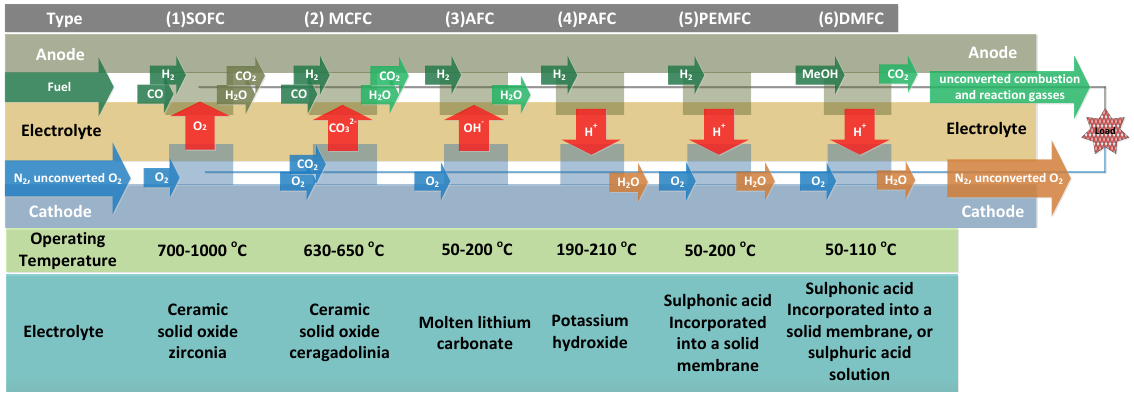
Figure 2. Schematic representation of a proton exchange membrane fuel cell (PEMFC) and a direct methanol fuel cell